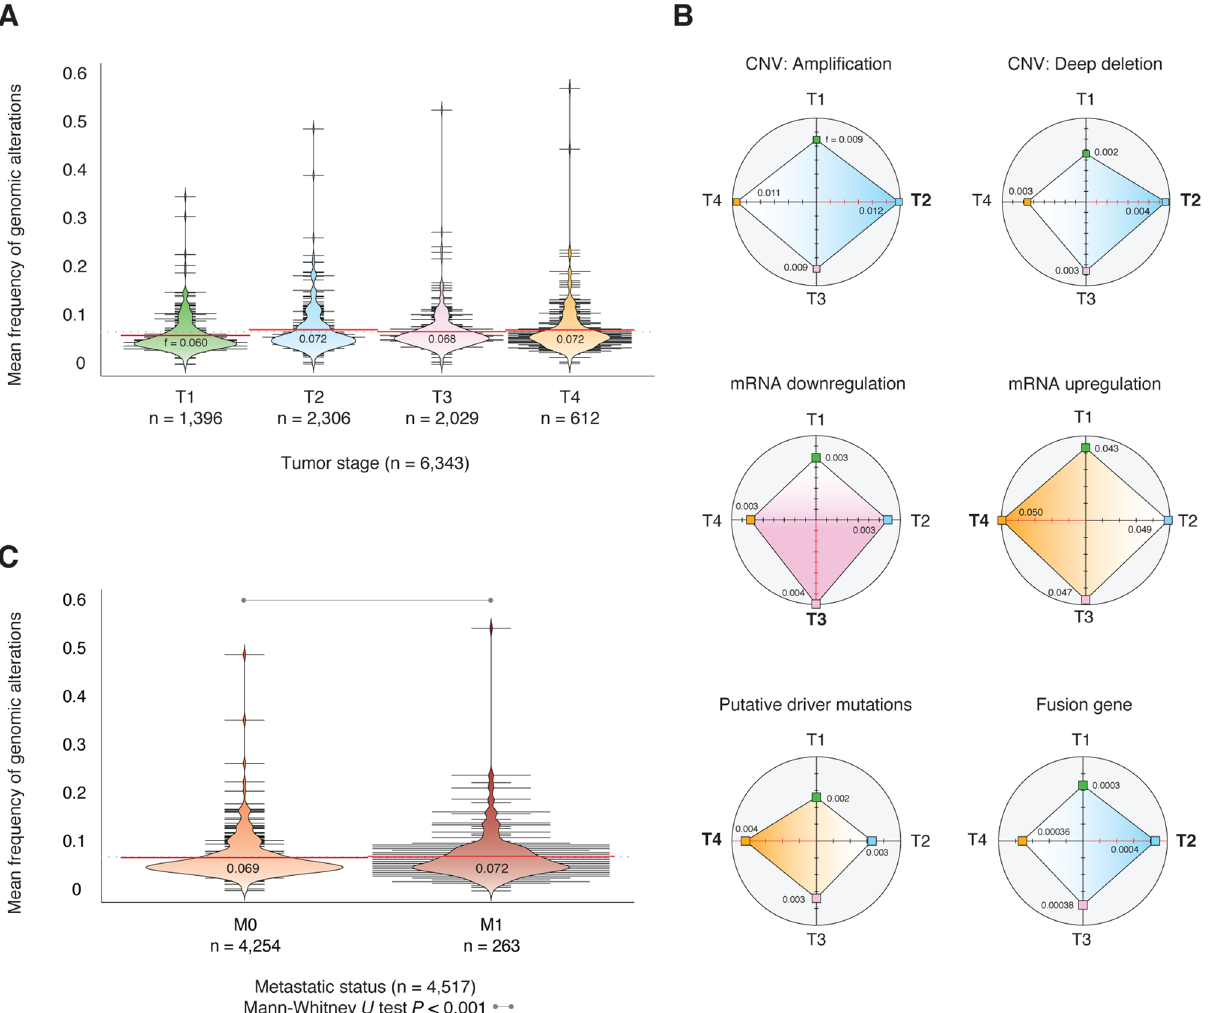
Figure 3. Tumor stages and metastatic status. ( A ) Mean frequency of genomic and transcriptomic alterations per tumor stage across 17 pancarcinomas from PCA-TCGA. ( B ) Mean frequency of each alteration type per tumor stage. ( C ) Mean frequency of genomic and transcriptomic alterations per metastatic status, and its validation through the Mann–Whitney U test ( P < 0.001). CNV: copy number